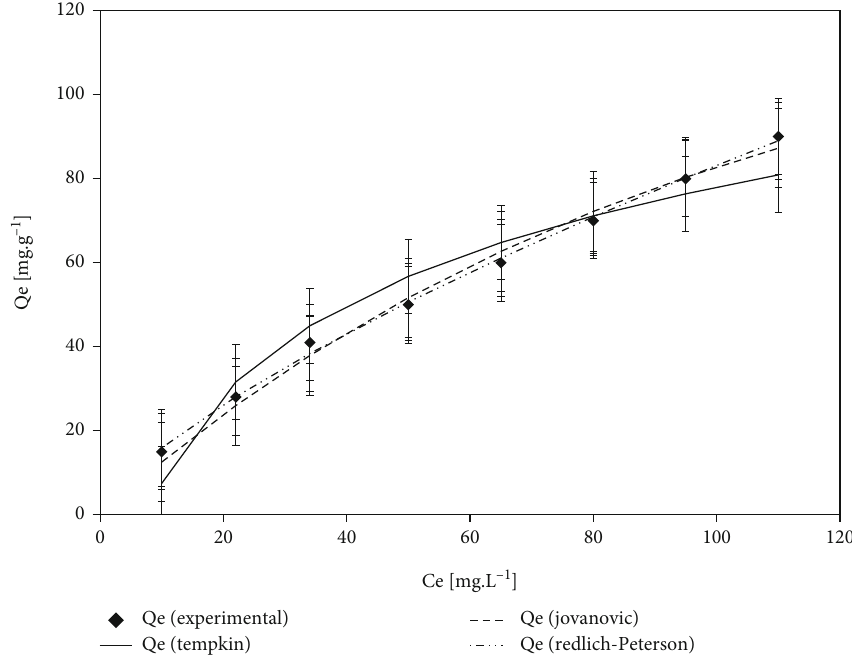
Figure 11: Adsorption data fi tting to Jovanovic, Tempkin, and Redlich-Peterson models.